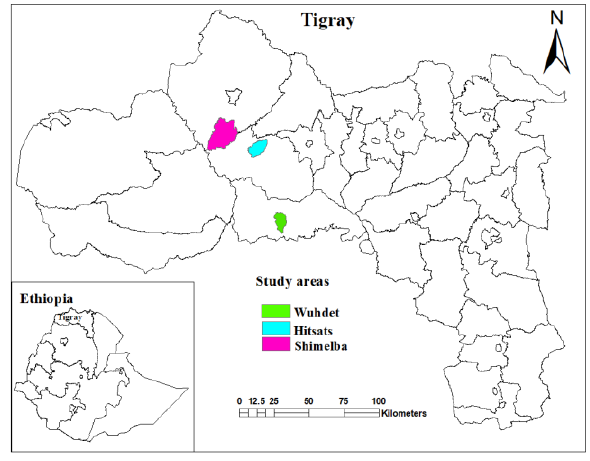
Fig. 1. Location of the study area